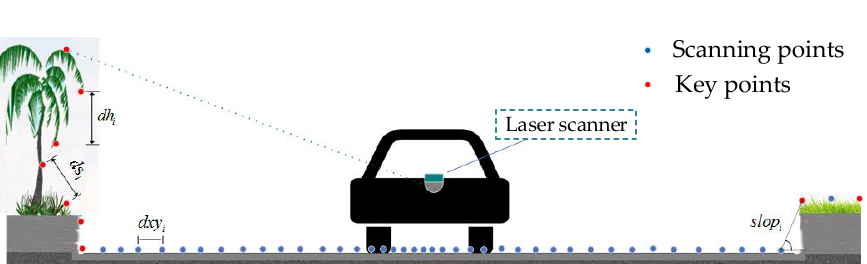
Figure 3. Sketch map of pavement point cloud extraction based on scan line.